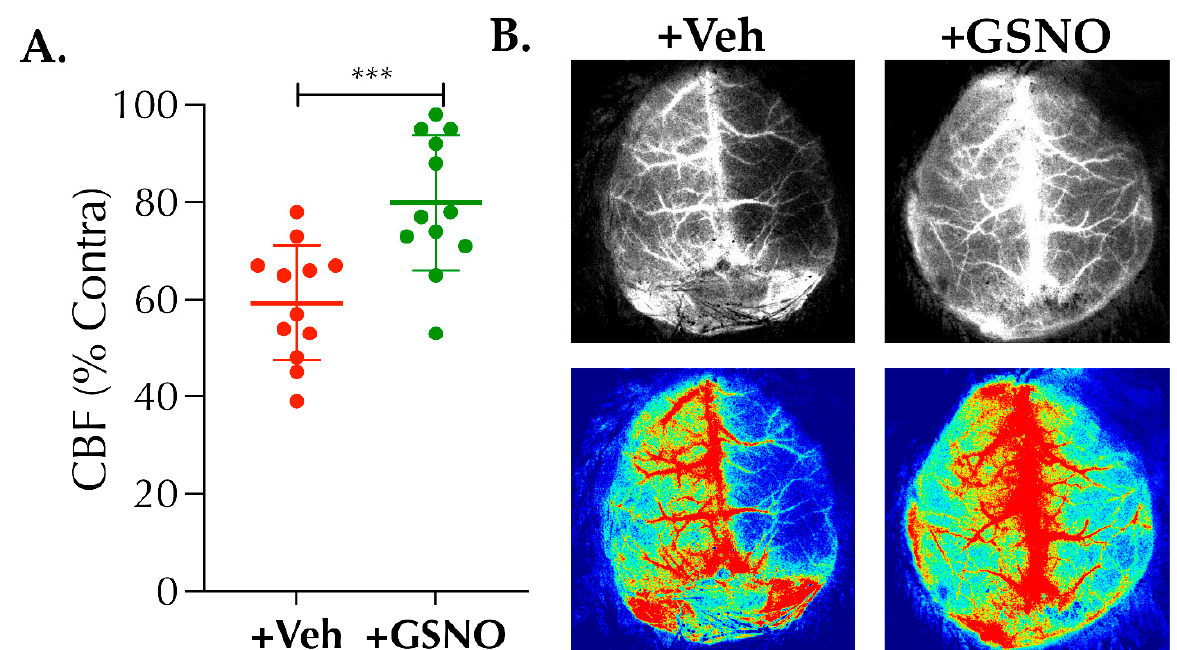
Figure 2. Nebulization of s-nitrosoglutathione (GSNO) following thrombotic stroke in diabetic mice enhances cerebral blood flow (CBF). Diabetic male mice (C57/B6 background, 14 ± 1-wks. old) were subjected to thrombotic (photothrombotic, PT) stroke. Mice were randomized and treated with either saline as vehicle (+Veh control group) or GSNO (+GSNO treated group; 100 µ g/kgbwt × 2 doses at 2 h and 6 h post-stroke) nebulized in a total volume of 1 mL over a period of 10 min. Relative CBF (% contra) was measured at 24 h post-stroke using a laser speckle contrast imager (LSCI). ( A ) GSNO nebulization in +GSNO group significantly enhanced the % CBF change as compared to the +Veh group (***, p = 0.0008). ( B ) Representative laser speckle maps (top greyscale images) and pseudo color images (bottom-colored) showing changes in CBF in +Veh and +GSNO groups as indicated. Data are presented as Mean ± SD ( n = 12 mice/group). Statistical significance was determined at p < 0.05 and using an unpaired t-test . No mortalities were observed by 24 h post-stroke at the time of LSCI procedure as rarely seen in this mini-infarct model of PT ‐ stroke.